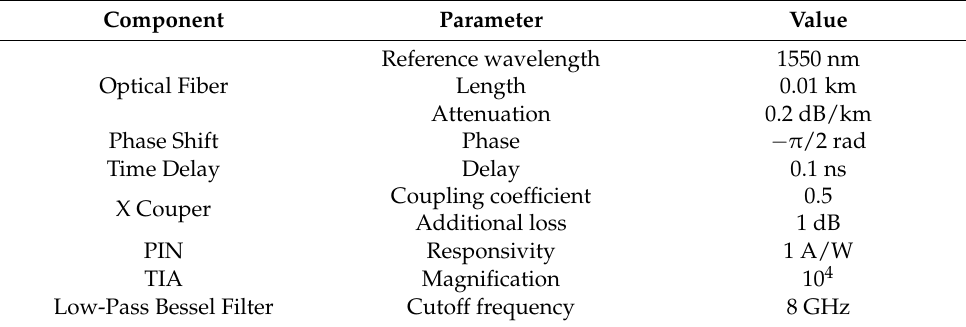
Table 4. Parameter design of the